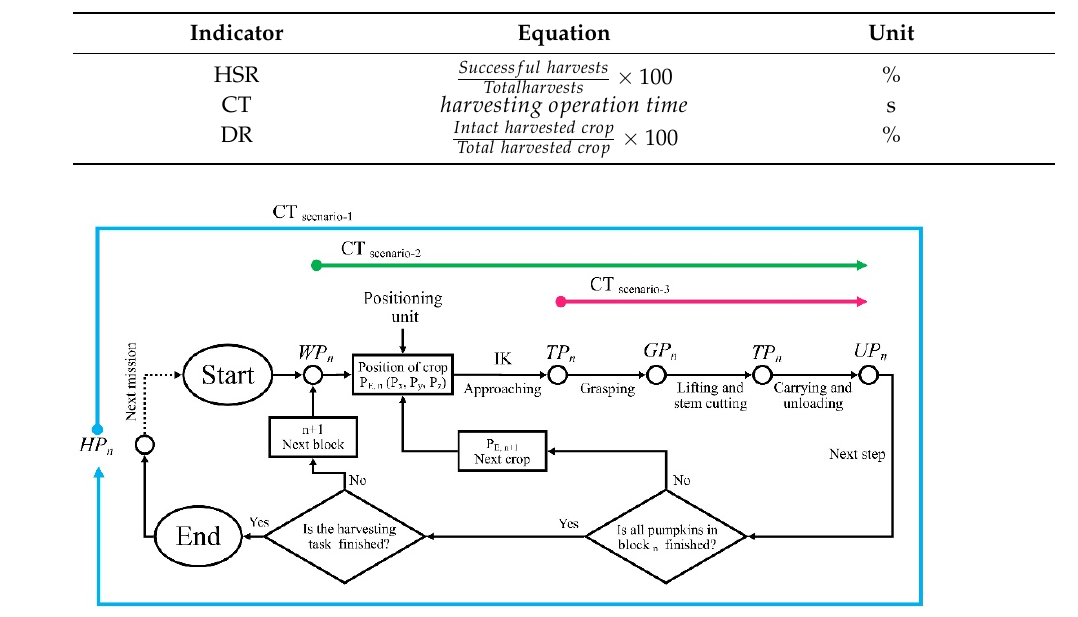
Table 3. Harvesting performance indicators.